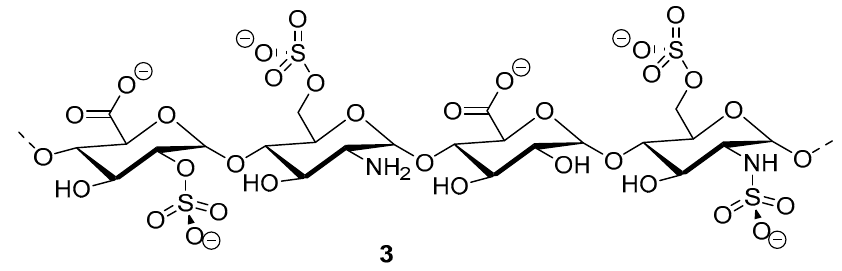
Figure 3. Structure of heparan sulfate ( 3